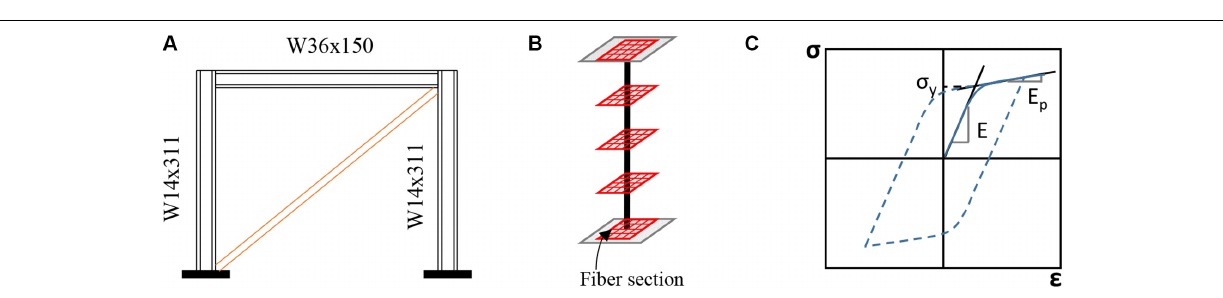
natural period of this CBF system was calculated to be 0.47